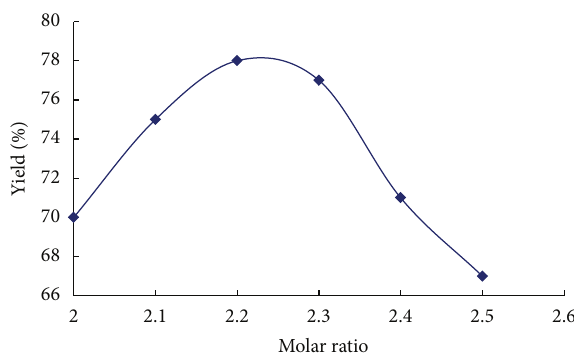
Figure 3: The effect of molar ratio on the